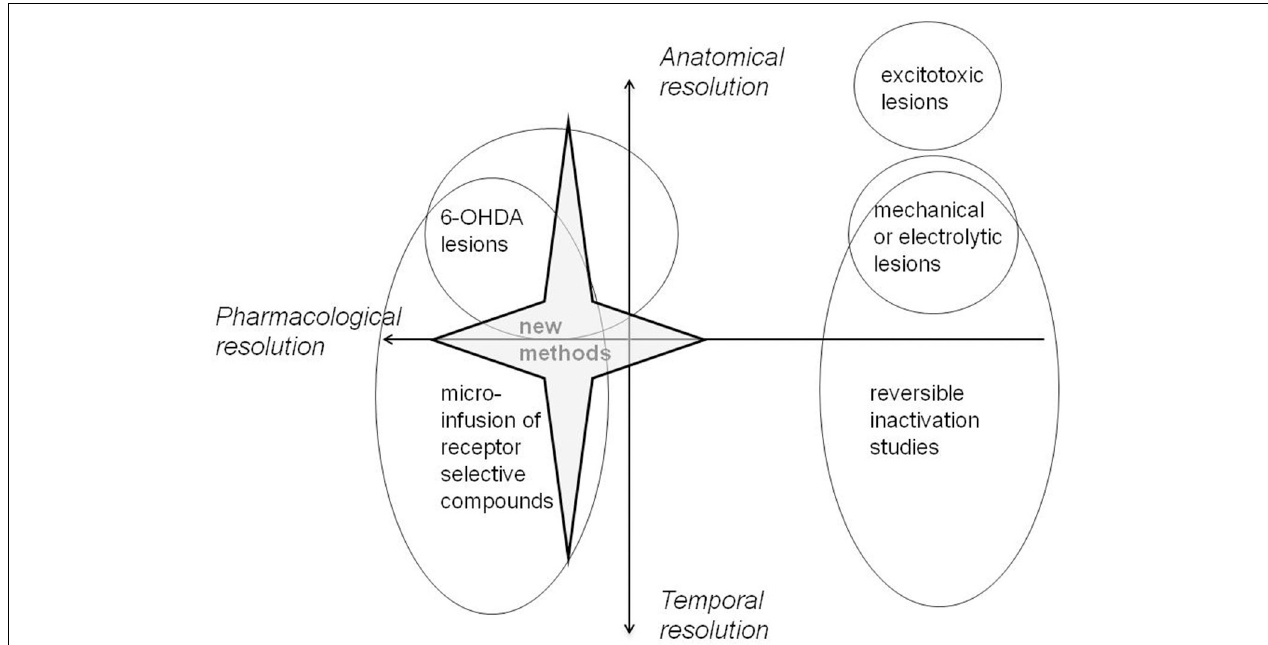
FIGURE 2 | A schematic representation of the anatomical (how precisely located), temporal (how well-specified in terms of duration of action), and pharmacological resolution afforded by the techniques most widely available to study medial prefrontal function in vivo . Whilst there is generally a trade-off between anatomical and temporal resolution, this